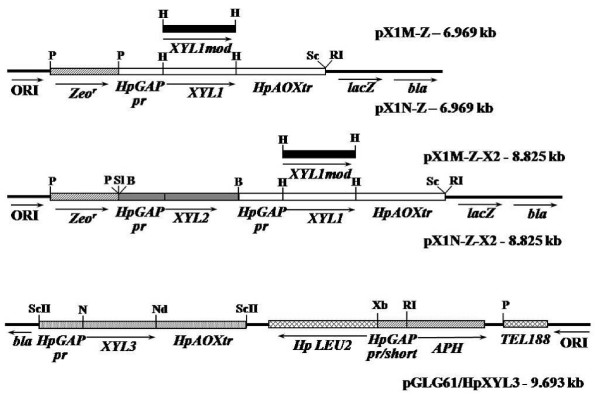
Linear schemes of the plasmids used in this study: pX1M-Z, pX1N-Z, pX1M-Z-X2, pX1N-Z-X2 and pGLG61/HpXYL3. Expression cassettes prGAP-XYL1-trAOX, prGAP-XYL2-trXYL2 and prGAP-XYL3-trAOX are shown as white, gray and doted boxes, respectively. The modified version of XYL1 ORF is shown as black box. The zeocin resistance gene (Zeor) and geneticin resistance gene (APH), linked to an impaired constitutive gene promoter, encoding glyceraldehydephosphate dehydrogenase (GAP) are designated with the hatched lines. H. polymorpha LEU2 gene and the telomeric region (TEL188) [30] as an autonomously replicating sequence are shown as cross-hatched lines. Origin of replication ORI and ampicillin resistance gene (bla) – arrows. Restriction sites: P, PstI; H, HindIII; S, SacI; Sl, SalI; B, BamHI; ScII, SacII; Xb, XbaI; RI, EcoRI; NdI, NdeI; N, NotI.